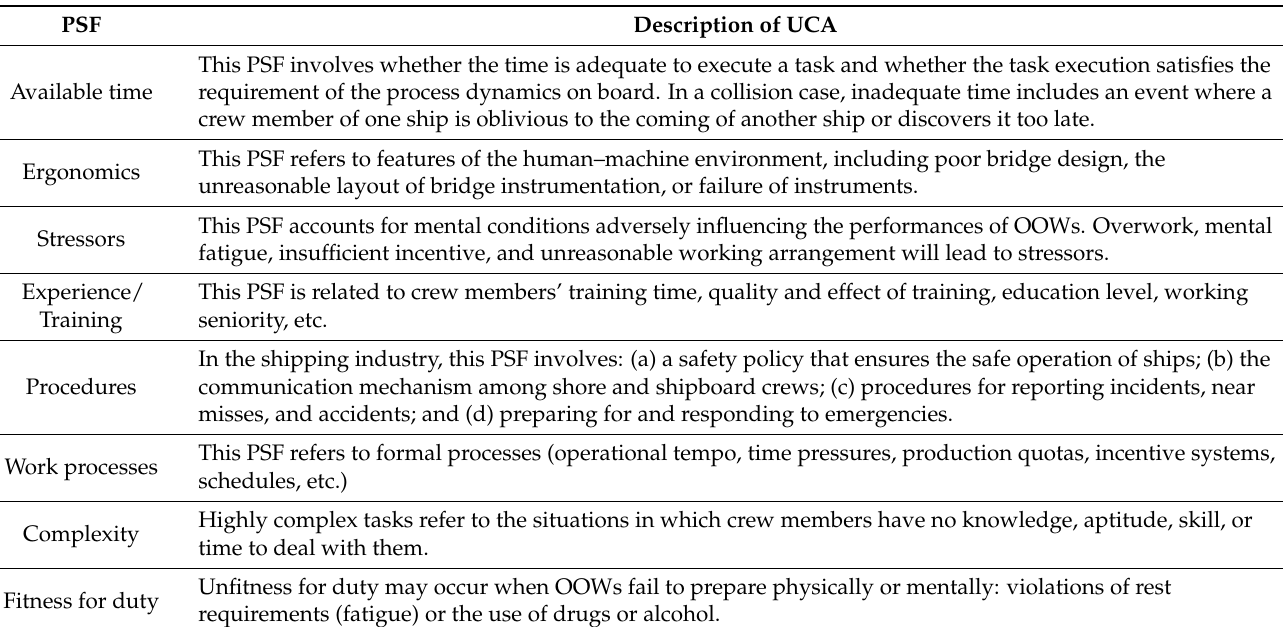
Table 2. Descriptions of PSFs and